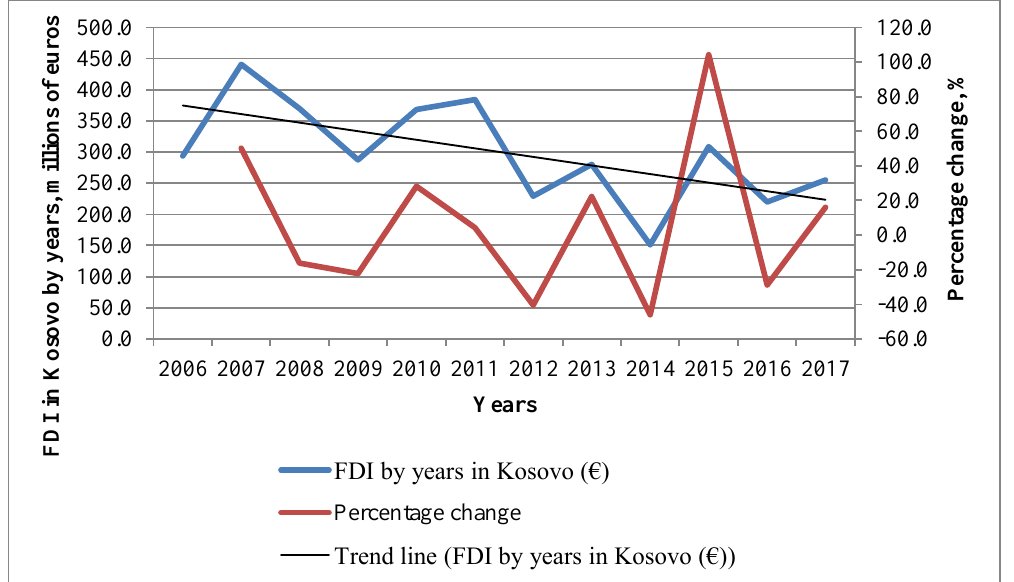
Fig. 1. FDI in Kosovo by years, 2006–2017, in millions of euros (developed by the authors based on CBK data,